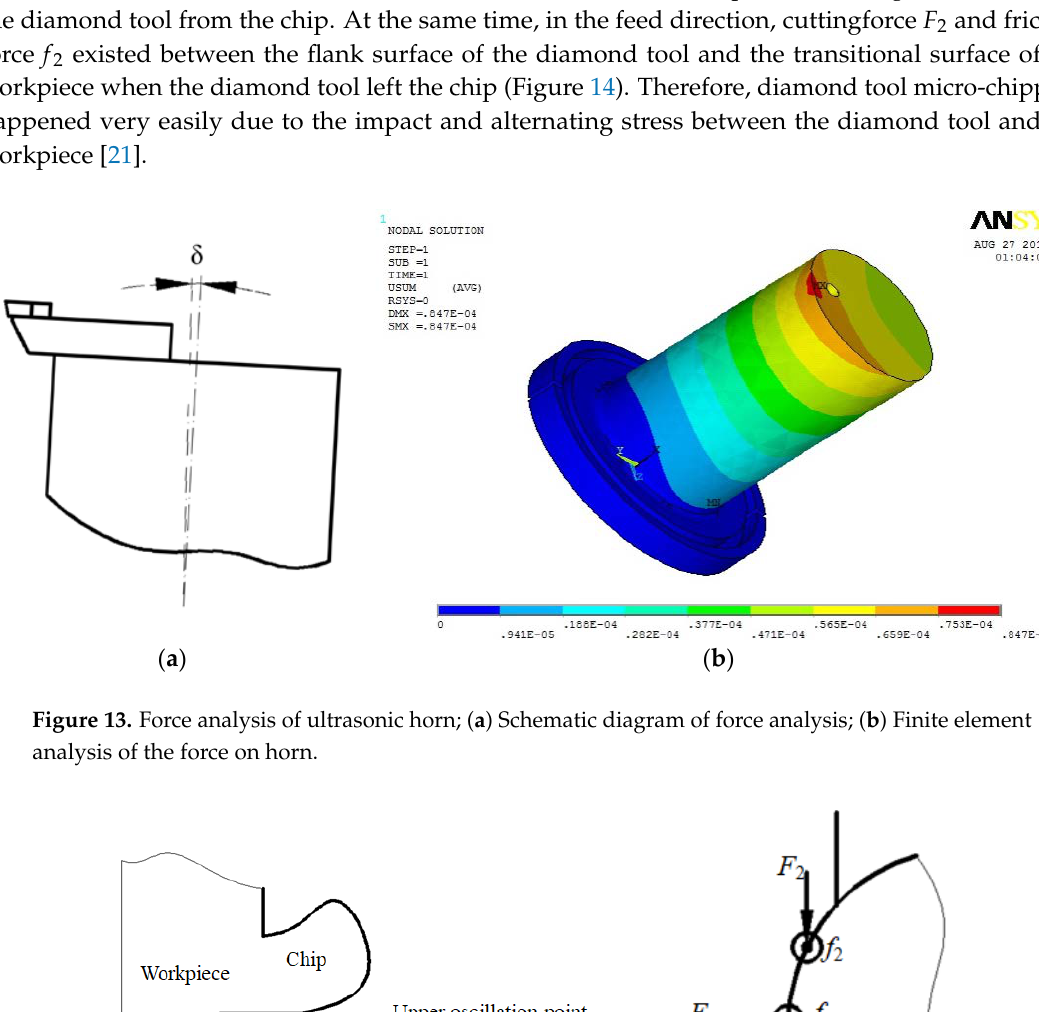
( b ) Figure 12. Surface topography of the machined workpiece after cutting along X -axis with a distance of 1 mm by a diamond tool with tip radius of 0.5 mm; ( a ) Ra 2.55 nm when diamond tool cutting in